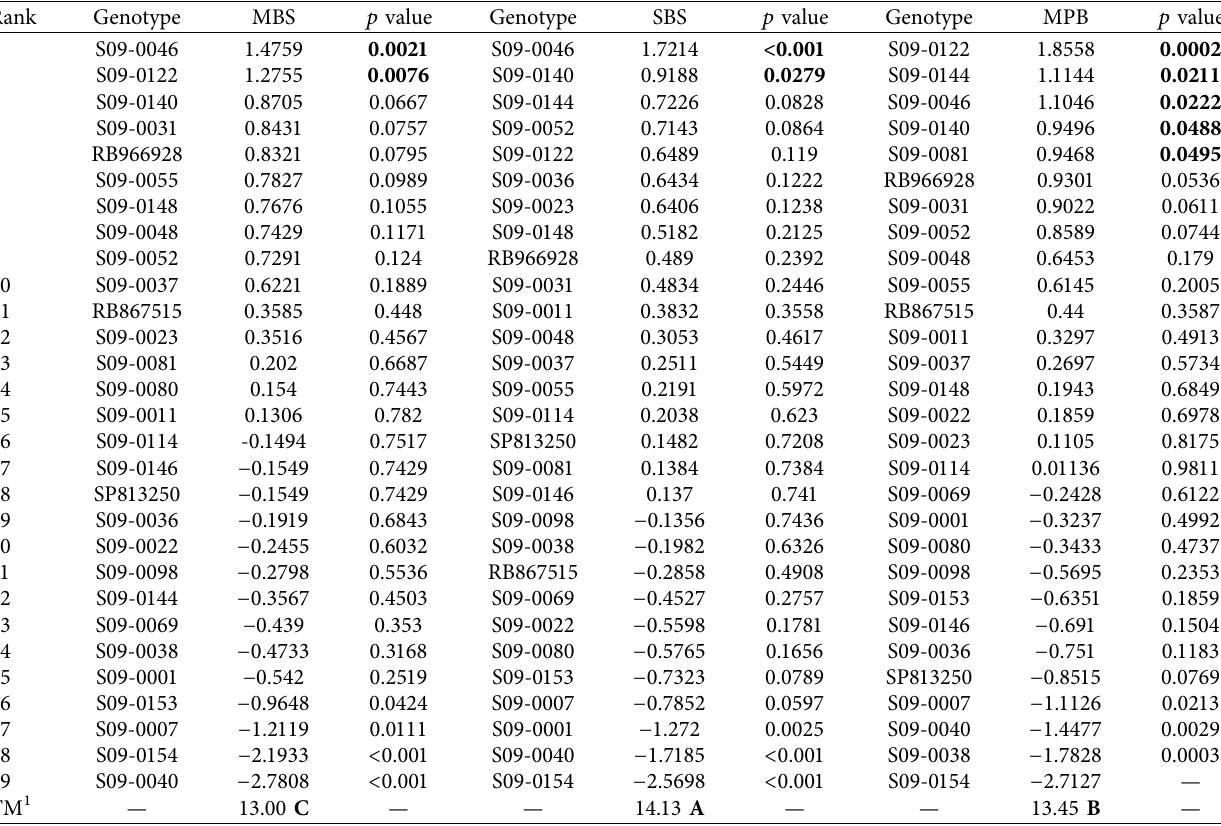
Table 7: Predicted genotypic differences (PGD) for POL_Brix across 29 genotypes (mean plant cane POL and 1st ratoon Brix) and three